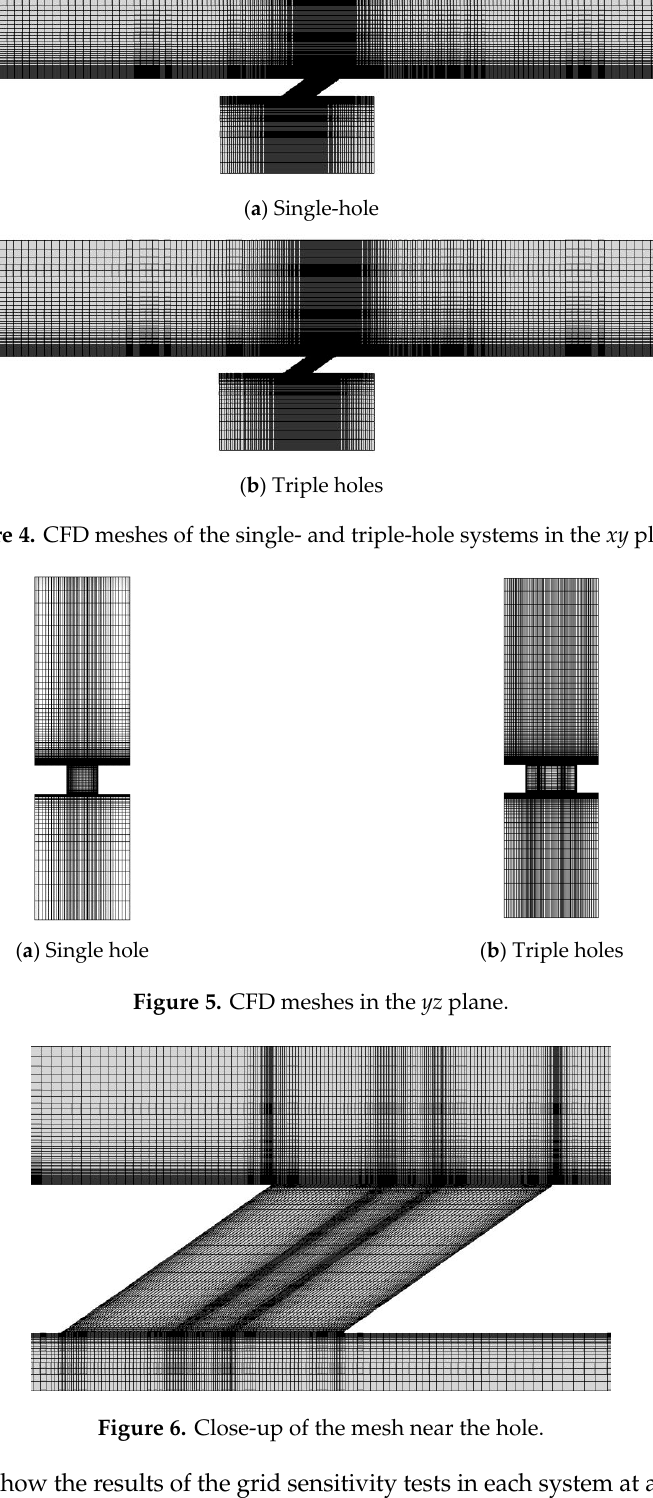
Figure 7. Grid sensitivity test of the large eddy simulation (LES) calculation in the single-hole system. Table 2. Specifications of mesh arrangements in the grid sensitivity test of the single-hole system. Grid Number of Cells in the x Direction